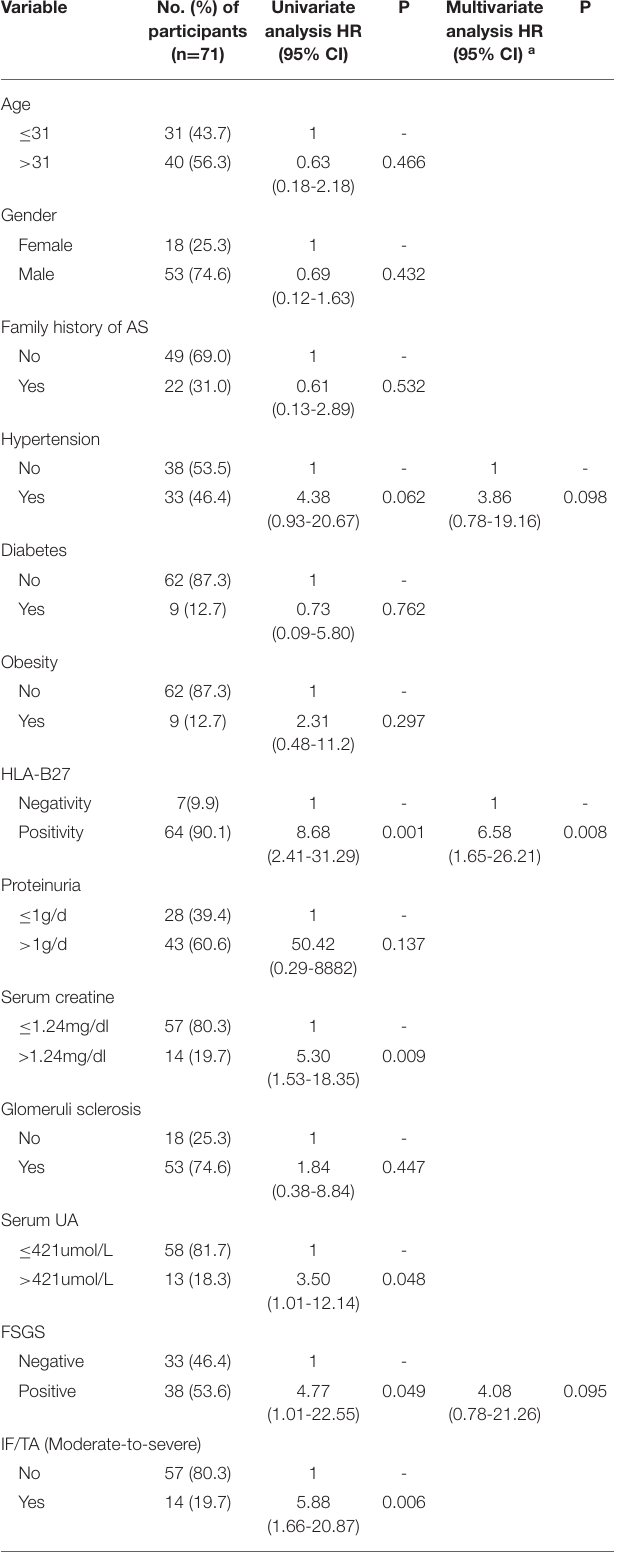
TABLE 2 | Univariate and multivariate Cox regression analysis of prognostic factors for renal function decline in AS patients with secondary IgAN.